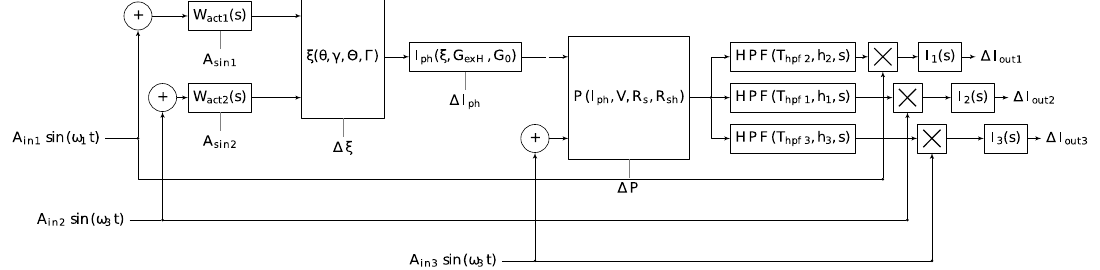
Figure 4. Open-loop general system.